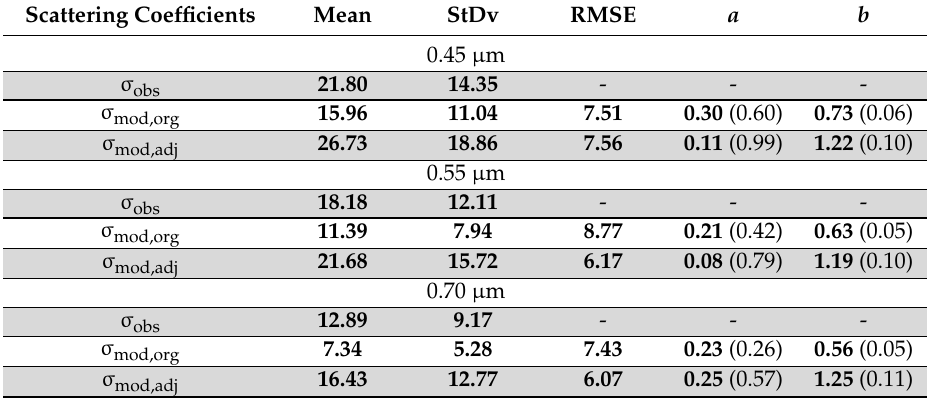
Table 2. Mean and standard deviation (StDv) of the observed ( σ obs ) and calculated ( σ mod,org and σ mod,adj ) scattering coefficients obtained for all TCAP FLs at three wavelengths. The corresponding intercept ( a ), slope ( b ), their standard errors (in parenthesis) and Root Mean Squared Error (RMSE) also are included. The RMSE is defined as the root mean squared difference between the observed and the calculated scattering